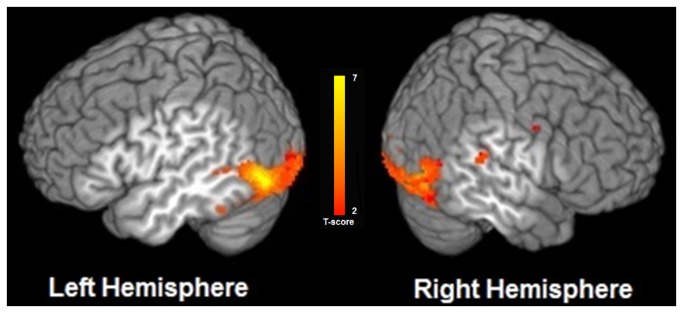
Group map illustrating regions significantly activated in the Audiovisual > Auditory-Speech Only contrast.Group activation map (N=18, false discovery rate q <0.05) overlaid on a surface-rendered template brain.